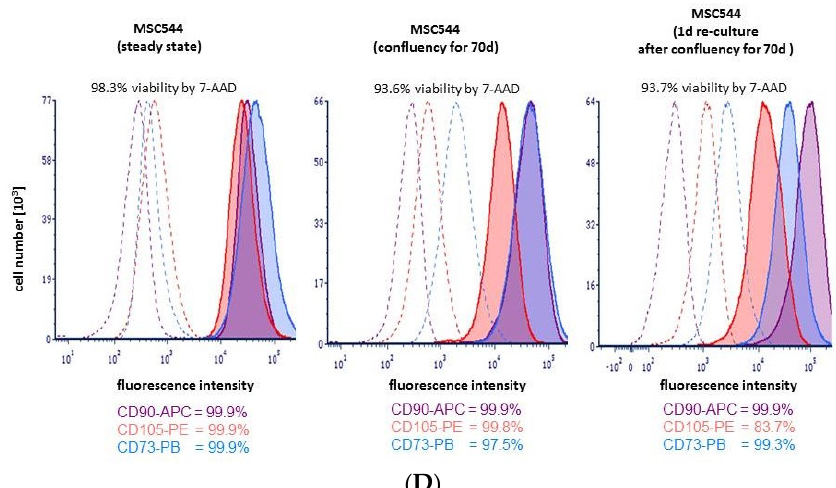
Figure 5. ( A ) Expression pattern of distinct genes was determined by RT-PCR in UC-MSC300415 in a low (P5) and high (P9) passage. Moreover, mRNA transcripts were evaluated in MSC544 P22 grown in confluency for 189d without subculture and compared to MSC544 grown in confluency for 189d and subcultured for additional 10d in P23 and 20d in P25, respectively. ( B ) Protein expression of p16 INK4A , p53, and human telomerase reverse transcriptase (hTERT) in UC-MSC300415 in a low (P5) and high (P9) passage was determined by Western blot analysis. Moreover, protein levels were evaluated in MSC544 P22 grown in confluency for 189d without subculture and compared to MSC544 grown in confluency for 189d and subcultured for additional 10d in P23 and 20d in P25, respectively. Expression of GAPDH was used as a control. ( C ) Cell cycle analysis of steady state MSC544 was compared to 152d continuously confluent MSC544 and after subconfluent re-culture of 152d growth-arrest MSC544 for 3d. ( D ) Simultaneous measurement of CD90-APC, CD105-PE, and CD73-PB by flow cytometry in steady state MSC544 as compared to MSC544 cultured for 70d in confluency and 70d confluent MSC544 after 1d re-culture in a sub-confluent environment. Viability of the cultures was assessed by 7-AAD staining.